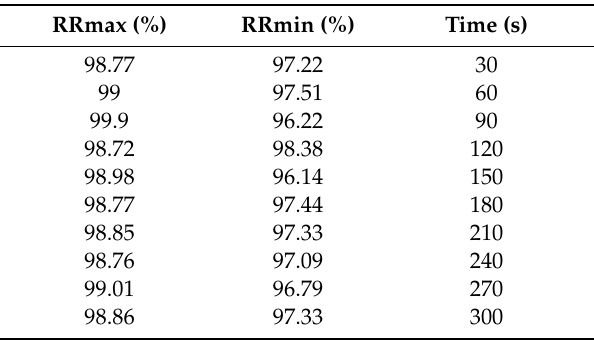
Table 3. Percentage relative range for RR